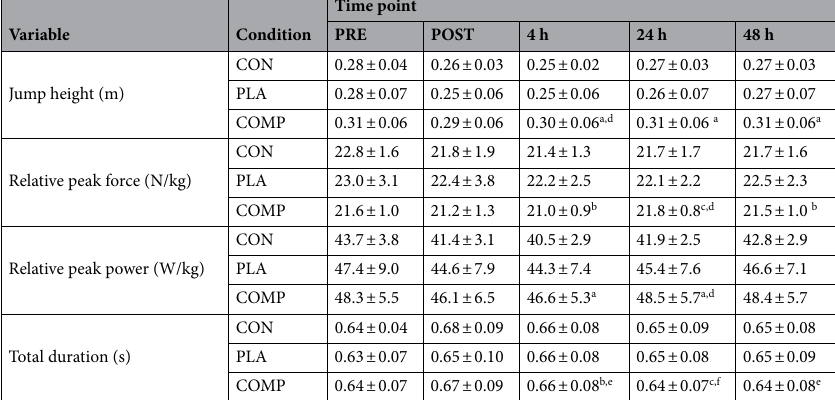
Table 2. Countermovement jump (CMJ) measures for CON, PLA and COMP conditions. Measures include jump height, relative peak force, relative peak power and total duration. Time points are before exercise (PRE), immediately post-exercise (POST), and 4, 24, and 48 h post-exercise. All data presented as mean ± SD. a Small effect as compared with CON. b Medium effect as compared with CON. c Large effect as compared with CON. d Small effect as compared with PLA. e Medium effect as compared with PLA. f Large effect as compared with PLA.